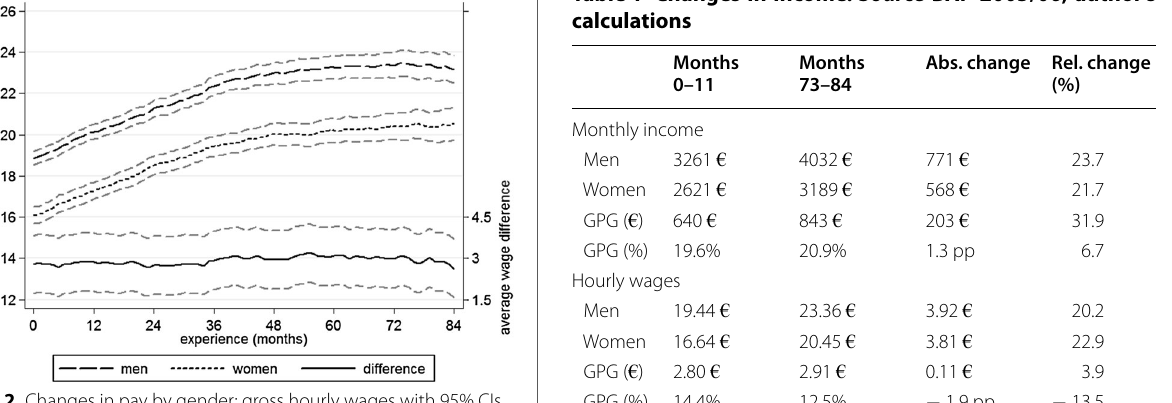
Table 1 Changes in income. Source BAP 2005/06,